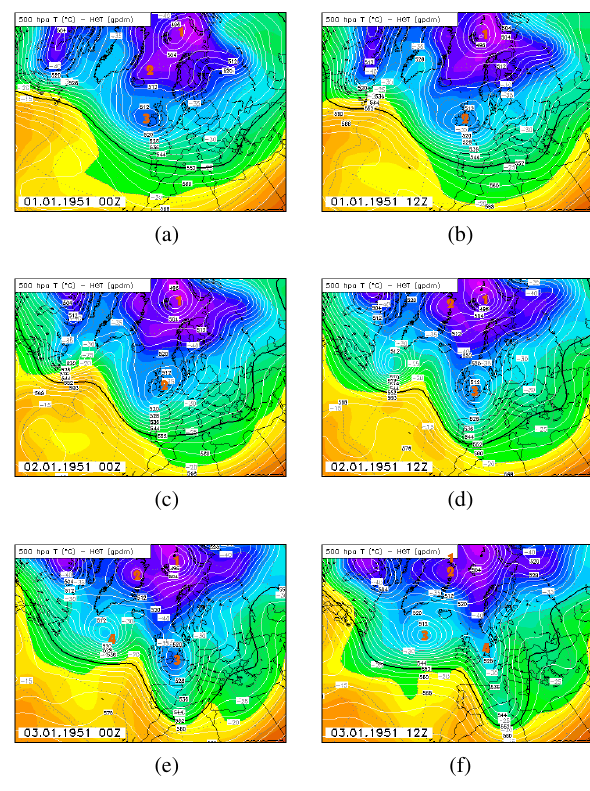
Figure 2. Series of 500hPa charts from 1 to 3 January 1951 (Source: www.wetterzentrale.de). The centers found by the identification algorithm are plotted in red; they are sorted by the intensity of the cyclone.